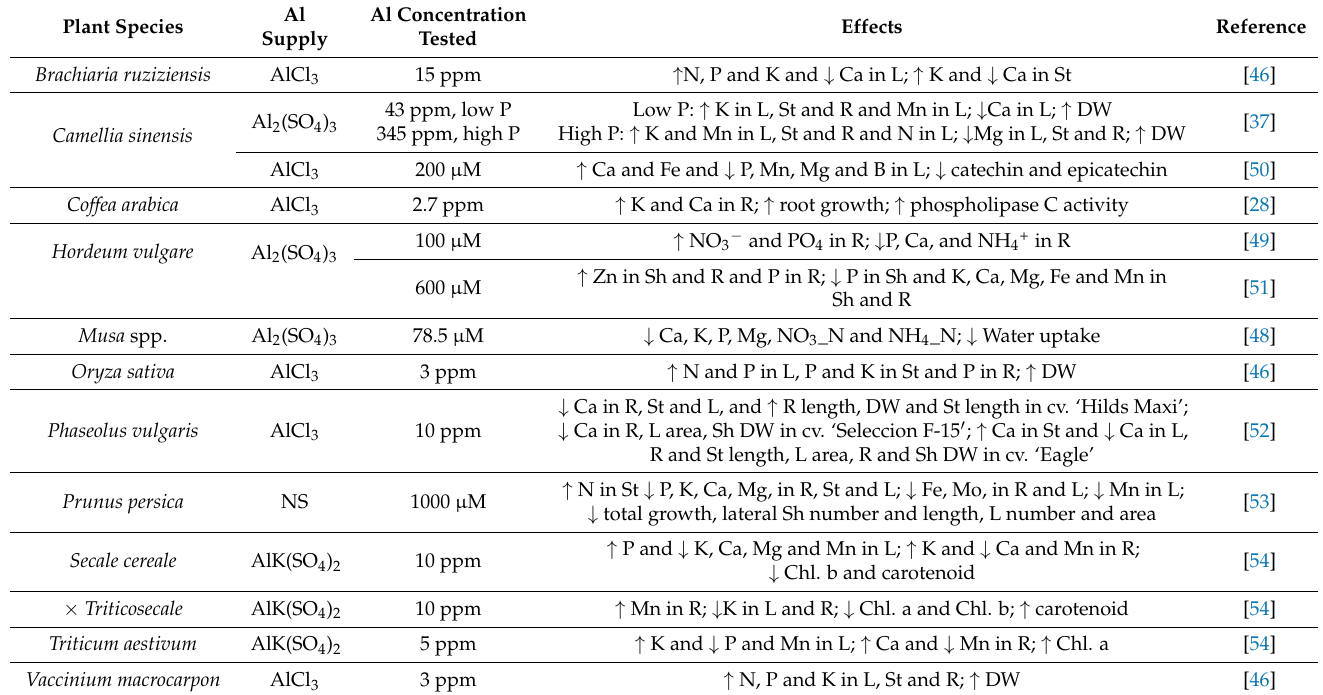
Table 1. Impact of aluminium (Al) root supply to plant mineral contents and physiological traits in several food and feed agronomical